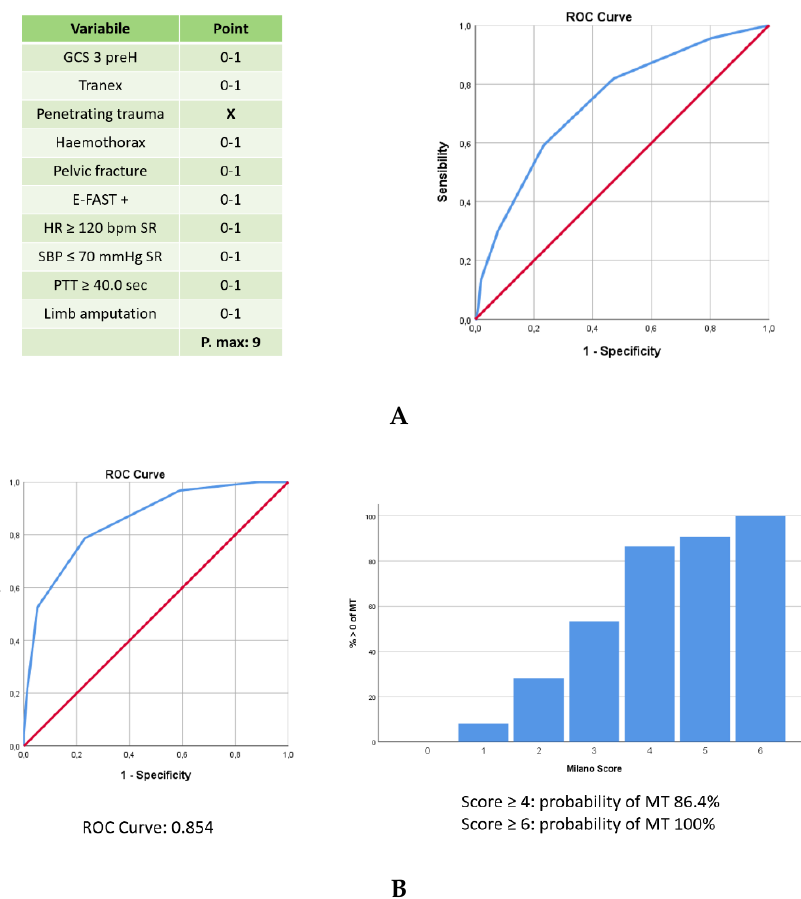
Figure 2. Variables considered in a multivariate analysis to elaborate the predictive score for MT. Figure 2 describes the ten variables used to elaborate the predictive score for MT, their ROC curves in the study populations, and the probability of MT of the validated “Milano score”. Particularly, Figure 2A lists the variables selected on a multivariate analysis tested on german population, identifying a score with AUC of 0.738. Figure 2B represents the validated score (Milano score), applied on Milano population, with an AUC of 0.854. The probability of MT according with different score values is depicted in the histogram. ( A ) Application of the predictive score of MT on the trauma population selected from DGU; ( B ) The predictive score of MT applicated on the Italian population.